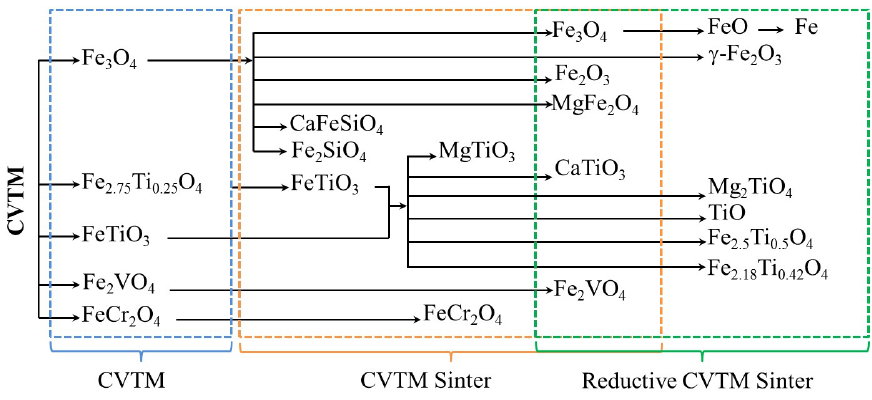
Figure 11. Phase transition path of CVTM sinter.